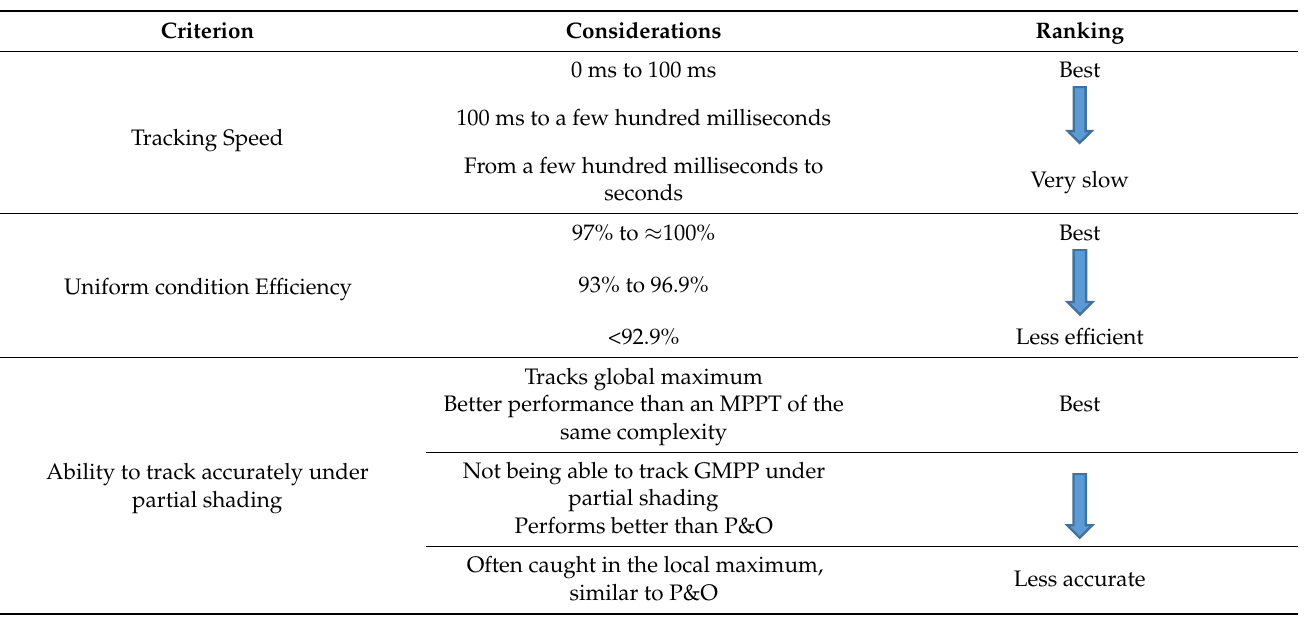
Table 7. Criteria for determining MPPT rankings redrawn with data from [43] .